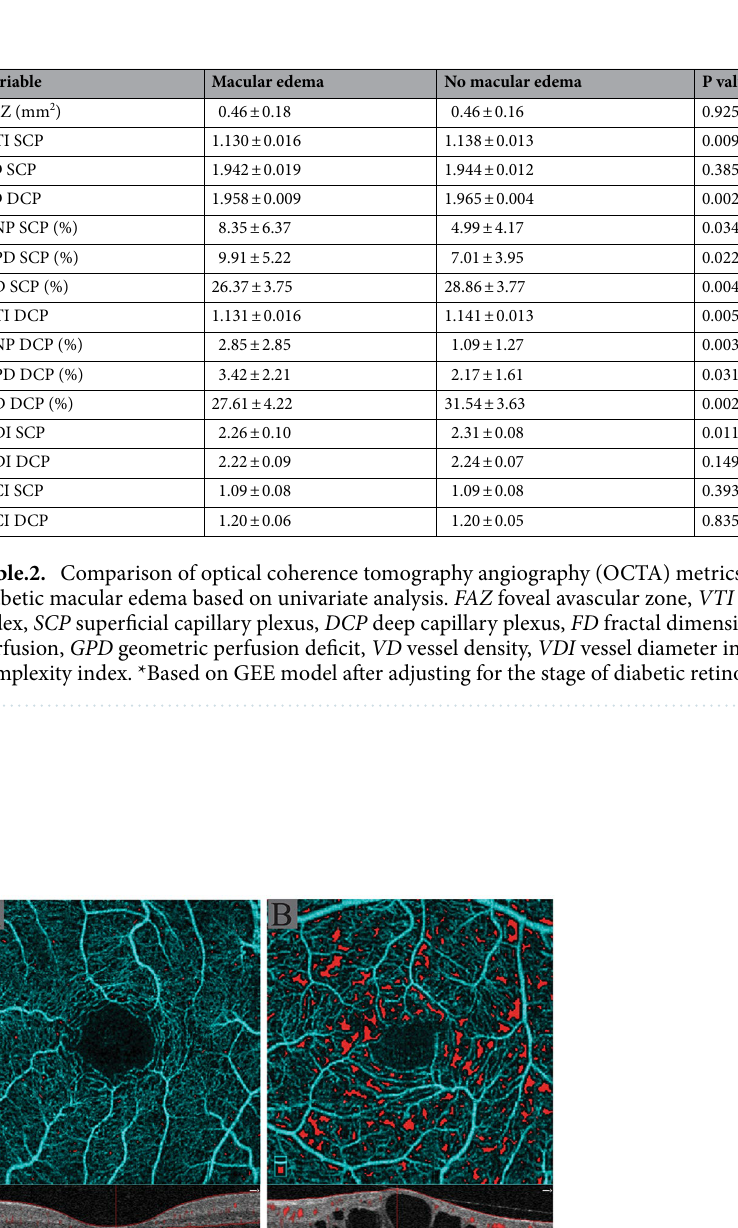
Table.1. Demographics of patients with diabetic retinopathy with and without diabetic macular edema. *T test. † Chi square test.